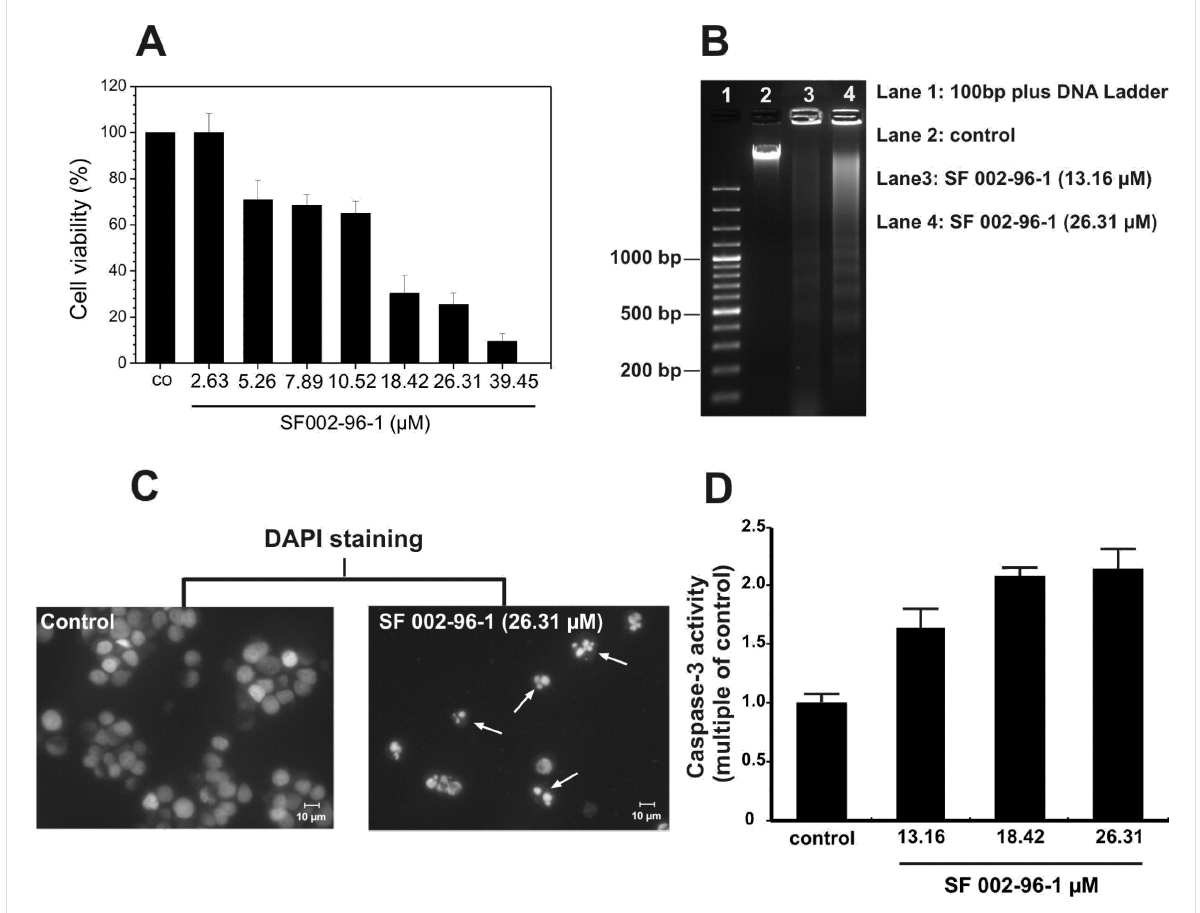
Figure 6: SF002-96-1 induces apoptosis of Colo 320 cells. (A) Colo 320 cells were treated without (control) or with SF002-96-1 at the indicated concentrations for 48 h. Cell viability was determined in triplicate using the XTT colorimetric assay. (B) Detection of DNA fragmentation by agarose gel electrophoresis after treatment of Colo 320 cells for 5 h with different concentrations of the test compound. Control: untreated cells only. (C) Morphology analysis of the cell nuclei by DAPI staining after treatment of Colo 320 cells with 26.31 µM of SF002-96-1 for 5 h. (D) Induction of apop- tosis by SF002-96-1 as measured by caspase-3 activity. Colo 320 cells were treated without (control) and with different concentrations of SF002-96-1 for 5 h. After lysis of the cells, 20 µM Ac-DEVD-AMC was added as fluorogenic substrate. AMC released from Ac-DEVD-AMC was measured by a spectrofluorimeter with excitation and emission wavelengths of 335 nm and 460 nm, respectively. Data are shown as mean values ± SD of three inde- pendent